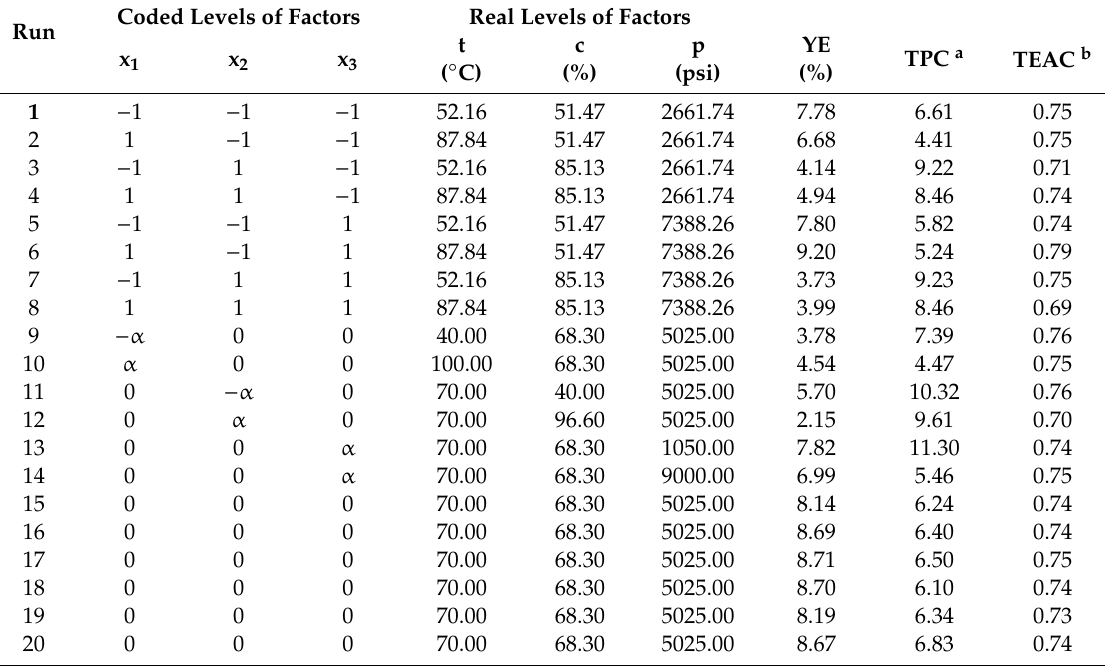
Table 2. Coded and real values of design of experiment